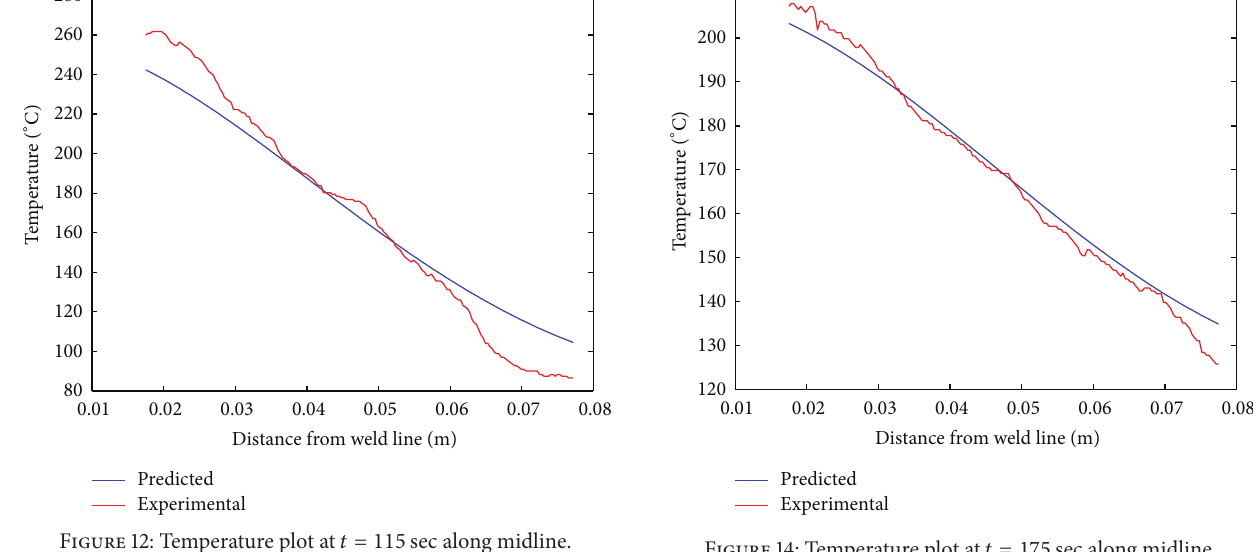
Figure 14: Temperature plot at 𝑡 = 175 sec along midline.